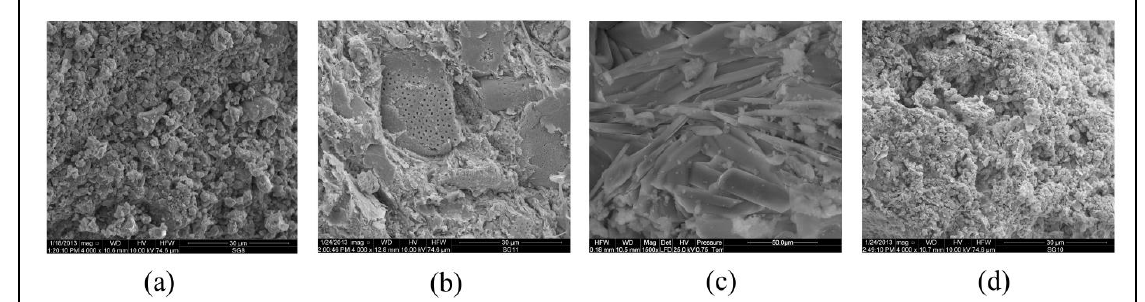
Table 2. Properties of soil amendments.